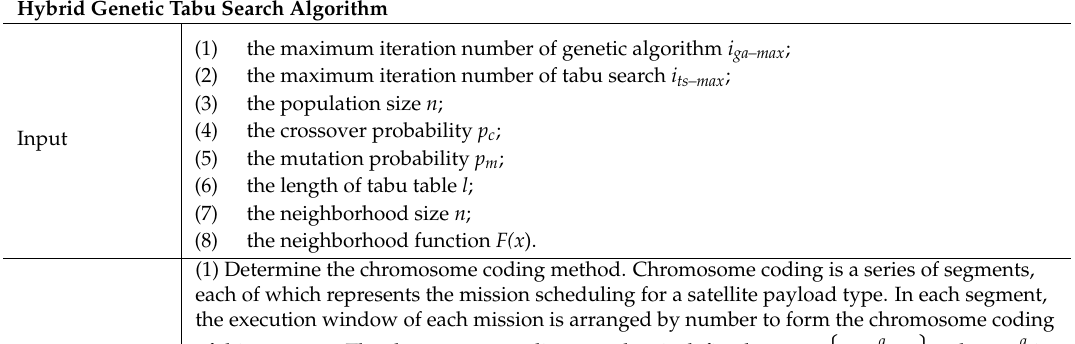
Table 4. Processing chain for the hybrid genetic tabu search